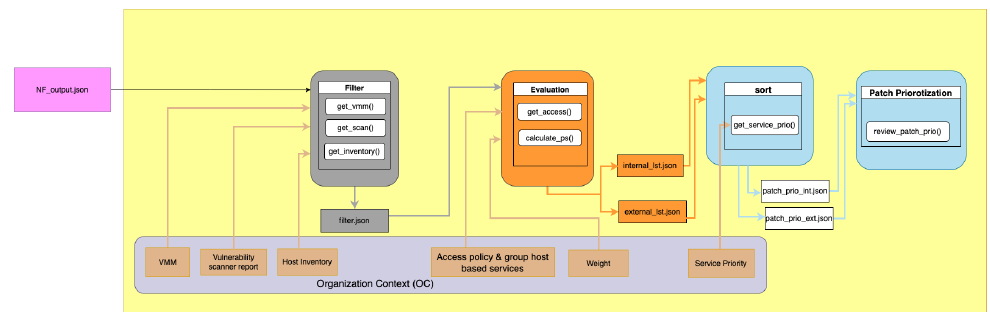
Figure 5. High-level software architecture of phase